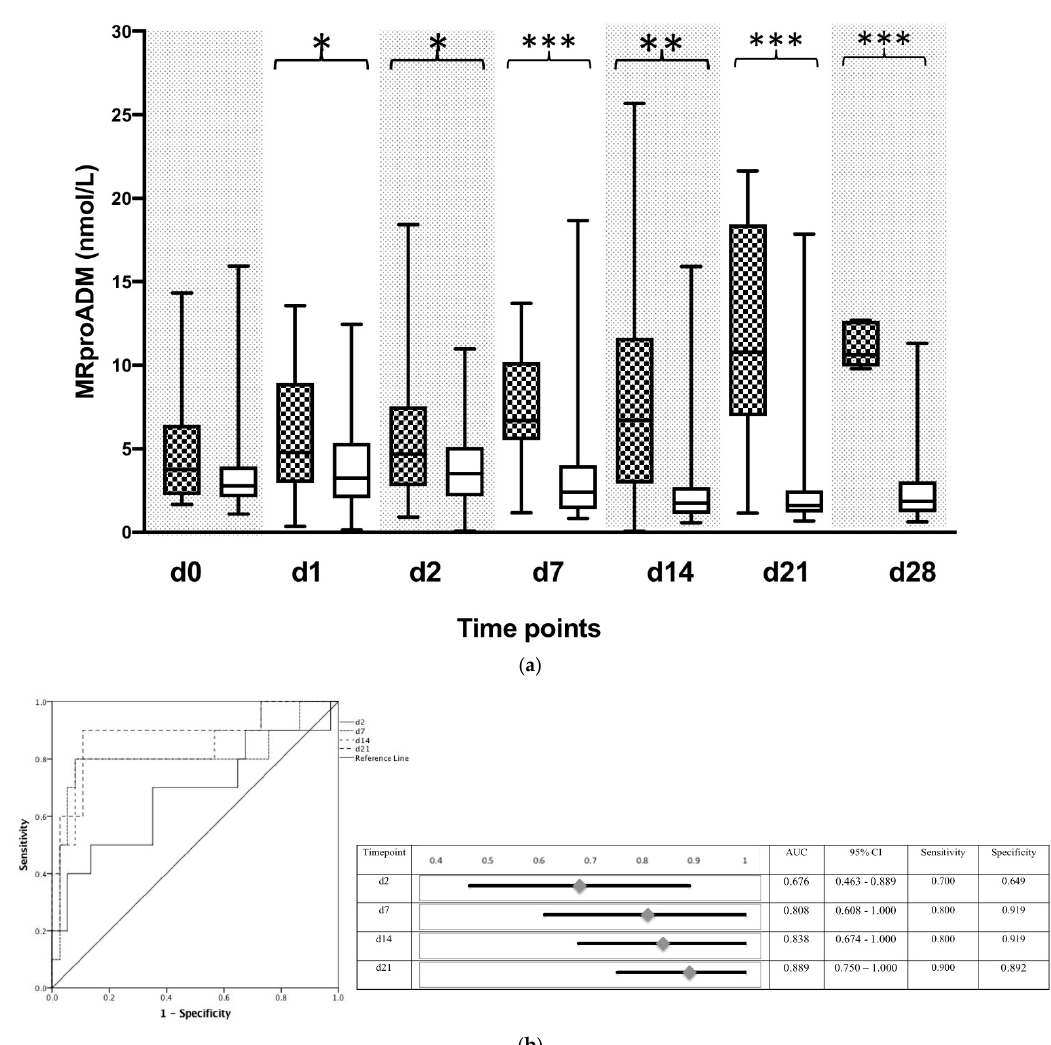
Figure 4. Plasma concentrations of mid-regional proadrenomedullin (MR-proADM) in patients following liver transplantation. ( a ) Plasma concentrations of MR-proADM were measured in patients following liver transplantation and divided according to their 90 d survival. MR-proADM is presented in nmol/L for 90-day survivors (white box) and 90-day non-survivors (black squared box). Plasma samples were collected immediately following liver transplantation (d0), and on day 1 (d1), day 2 (d2), day 7 (d7), day 14 (d14), day 21 (d21), and day 28 (d28) afterwards. Data in box plots are given as median, 25th percentile, and 75th percentile, with the 10th and 90th percentile at the end of the whiskers. Concerning symbolism and higher orders of significance: p < 0.05: *, p < 0.01: **, p < 0.001: ***. Mann–Whitney U Test. ( b ) Receiver operating characteristic (ROC) analysis with MR-proADM in all participating patients at day 2 (d2), as well as day 7 (d7), day 14, and day 21 (d21) afterwards with regard to the prediction of 90-day survival. Patients who died within 90 days after liver transplantation represented the target group, whereas surviving patients served as controls for this ROC analysis.